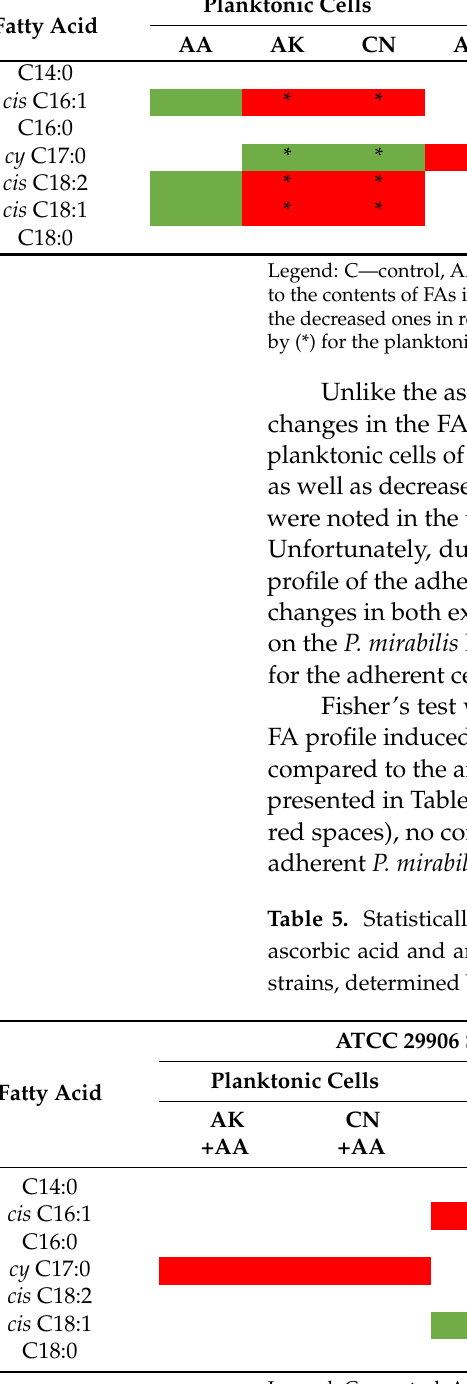
marked in green, and the decreased ones in